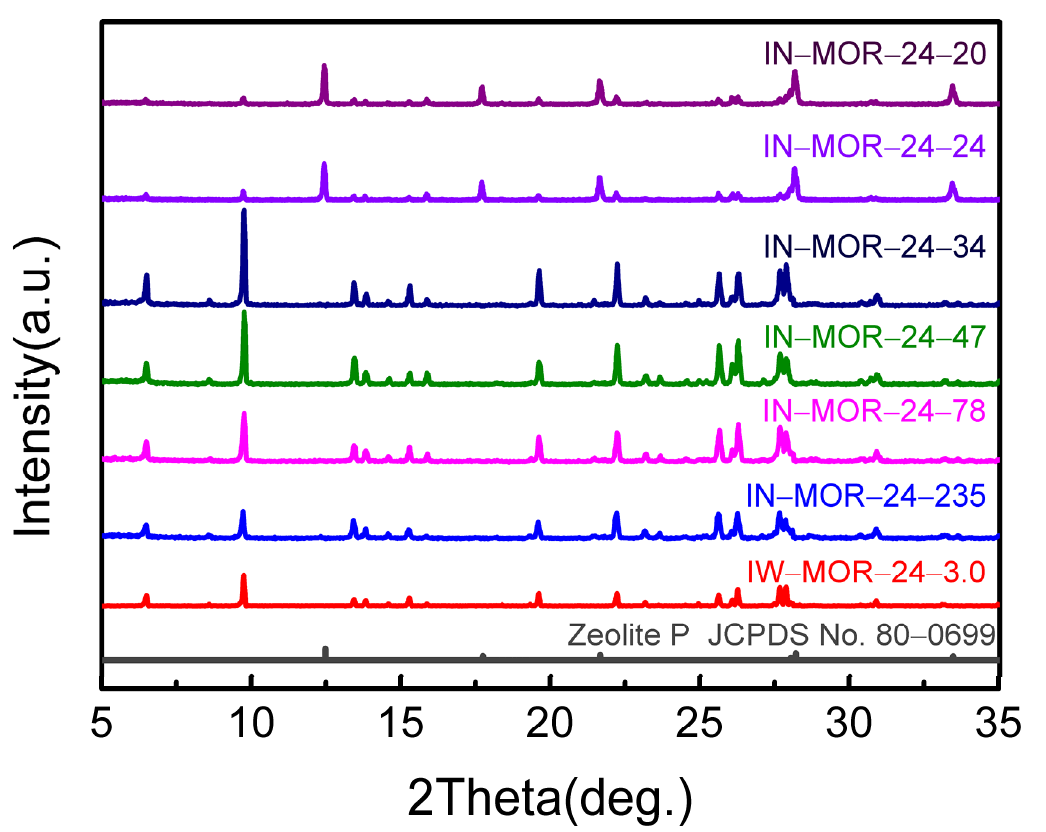
Figure 3. XRD patterns of IN–MOR–24 samples synthesized with various Al 2 O 3 /Na 2 O ratios.